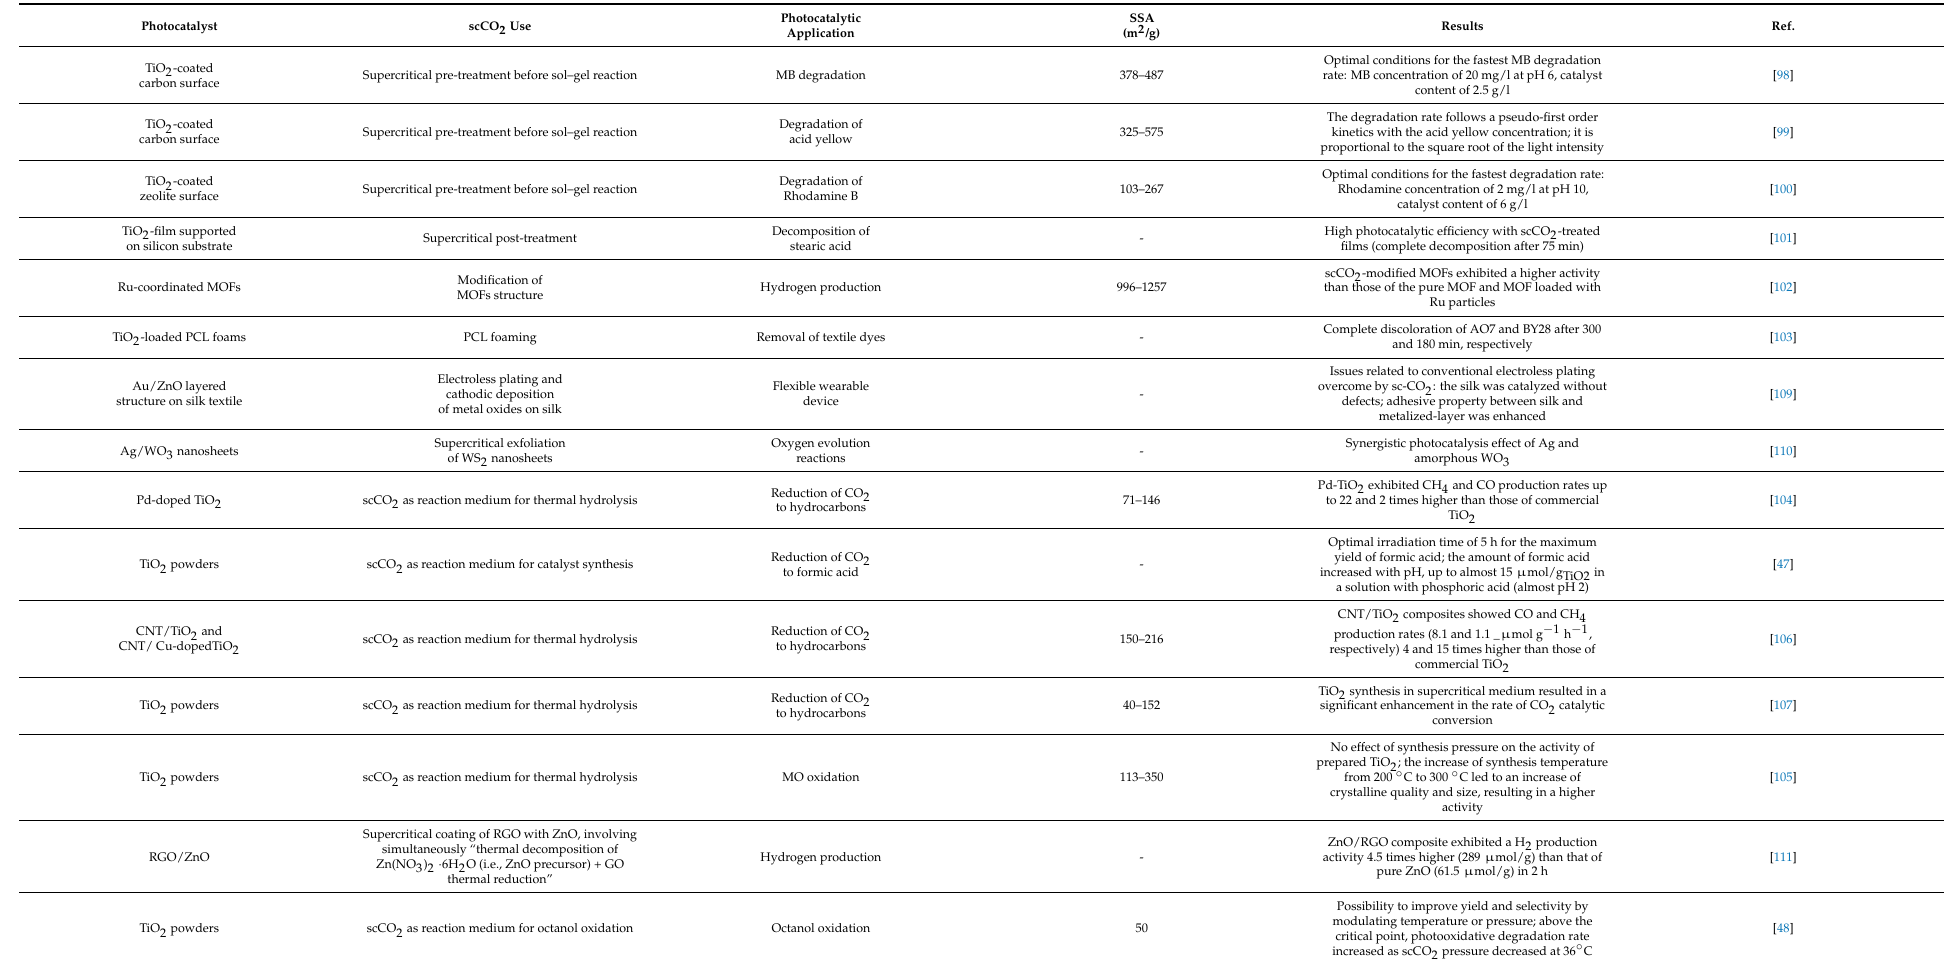
Table 4. Other applications of scCO 2 in photocatalysis. AO7= Acid Orange 7; BY28: Basic Yellow 28; CNT= carbon nanotubes; MO = methyl orange dye; MOFs= metal −